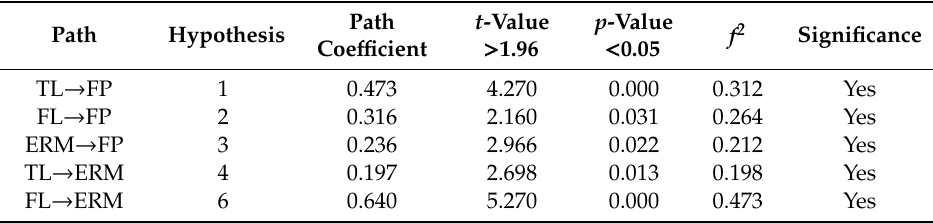
Table 6. Direct path coe ffi cients of the structural model.